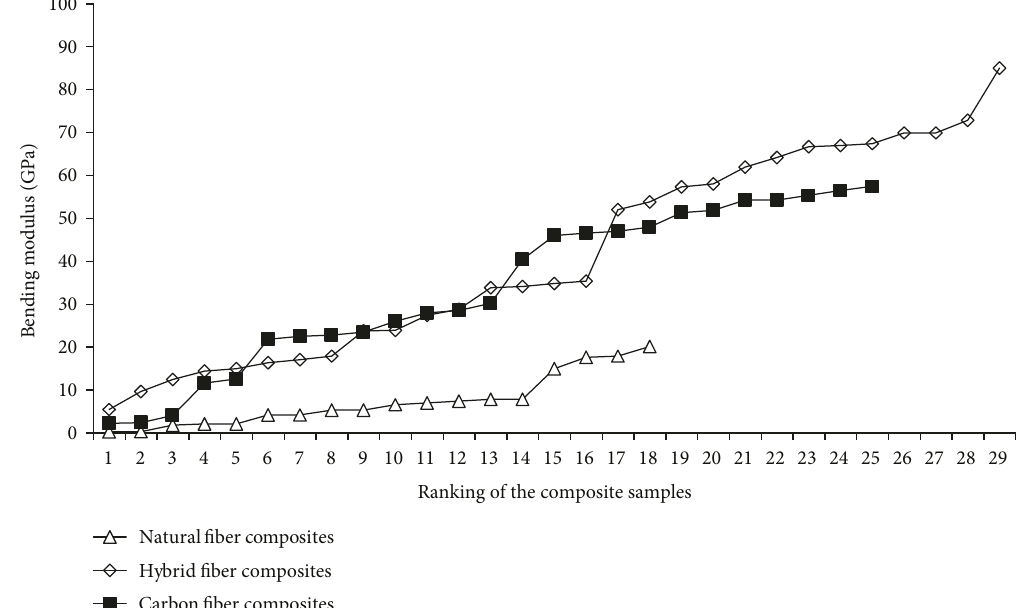
Figure 5: Bending modulus of hybrid carbon-/ fl ax- and nonhybrid carbon- and fl ax-epoxy composites [8, 9, 12, 13, 15, 17, 21, 22, 26, 40, 43, 45, 46, 51 –